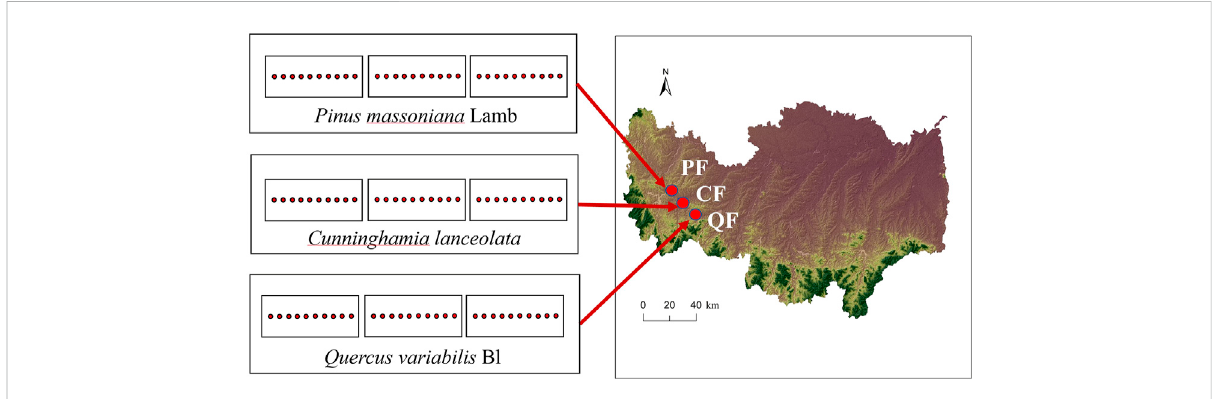
FIGURE 3 Map of the sampling location and the sampling scheme. QF, Quercus variabilis forest; PF, Pinus massoniana forest; and CF, Cunninghamia lanceolata forest. Each site has three random plots with 10 sampling sites in each